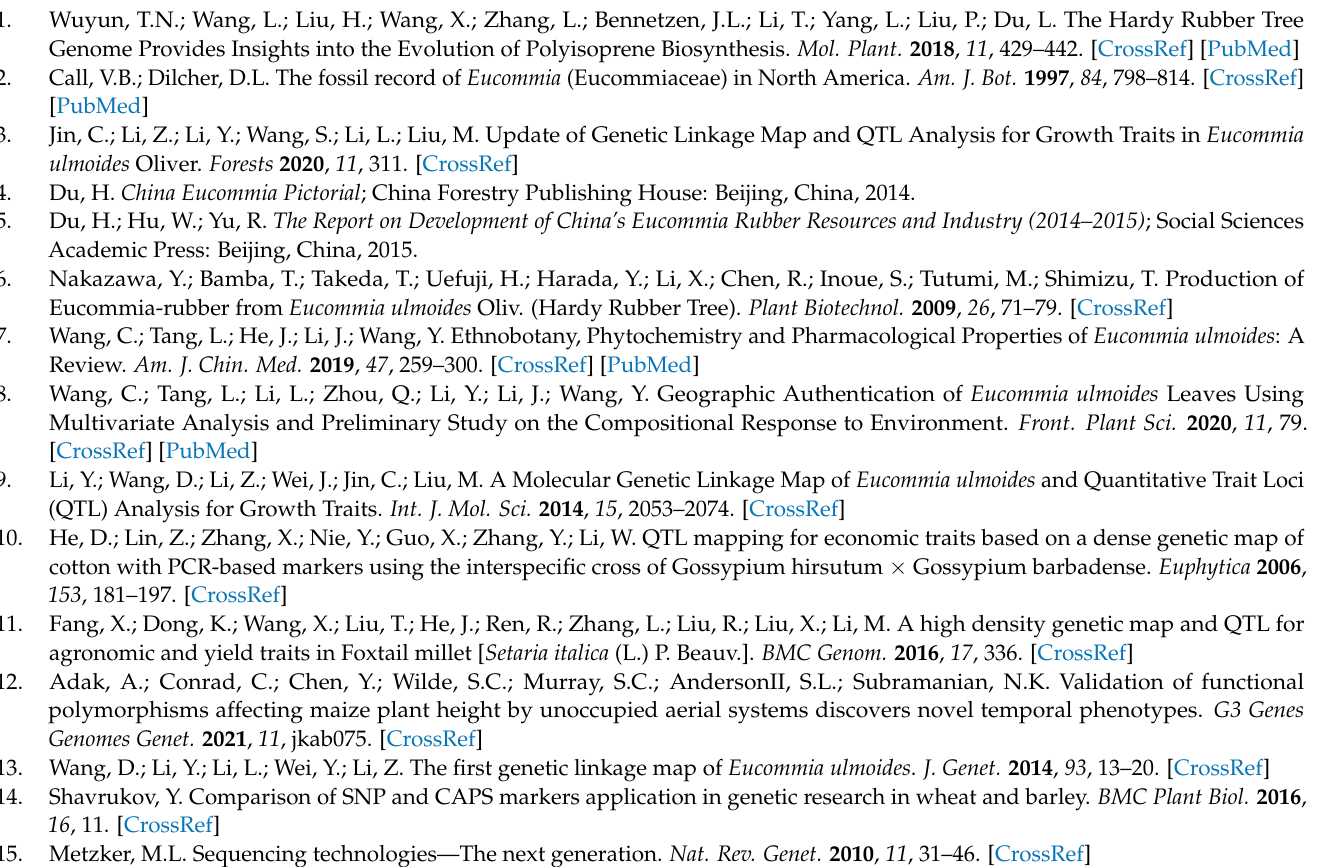
map of E. ulmoides ; Figure S2: Male (‘Huazhong 12’) genetic map of E. ulmoides ; Table S1: Data of three growth traits of 109 progenies; Table S2: Description of three growth traits of 109 progenies; Table S3: Summary of Genotyping by Sequencing data of Two parents and 109 progenies; Table S4: Detection result of SNP markers; Table S5: Summary statistics of parent linkage map of E. ulmoides ; Table S6: Annotation of 33 candidate genes related growth traits of E. ulmoides ; Table S7: QTLs detected for two growth traits (basal diameter and tree height) by using integrated genetic